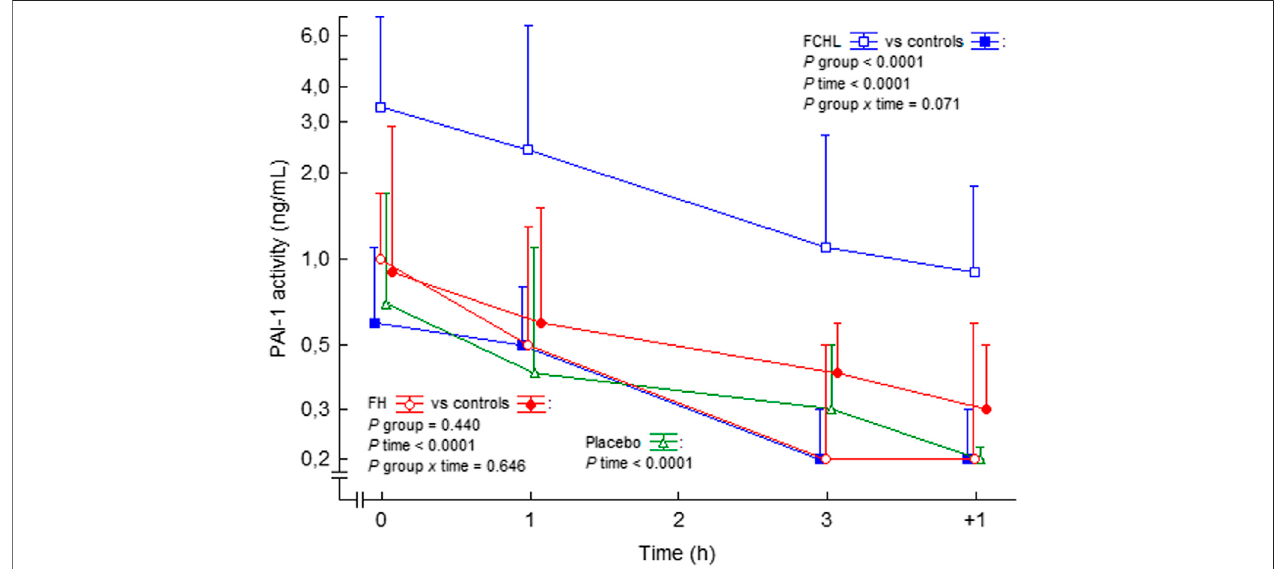
FIGURE 8 | PAI-1 activity in plasma before, during and after intravenous 3 h steady state angiotensin II infusion in man. Data are presented as median values and interquartile ranges. Statistical evaluation was made by repeated measures ANOVA. PAI-1, plasminogen activator inhibitor-1; FCHL, familial combined hyperlipidemia; FH,familialhypercholesterolemia.FCHL,bluelineandun fi lledsquares( n (cid:1) 16);FCHL-control,bluelineand fi lledsquares( n (cid:1) 16);FH,FH,redlineandun fi lledcircles( n (cid:1) 16),andFH-control,redlineand fi lledcircles( n (cid:1) 16).Theeffectofphysiologicalsalineinfusioninplaceboexperiments,greenlineandun fi lledtriangles( n (cid:1) 8),isalso shown. Data from (Ekholm et al., 2009; Ekholm et al., 2015; Ekholm et al.,